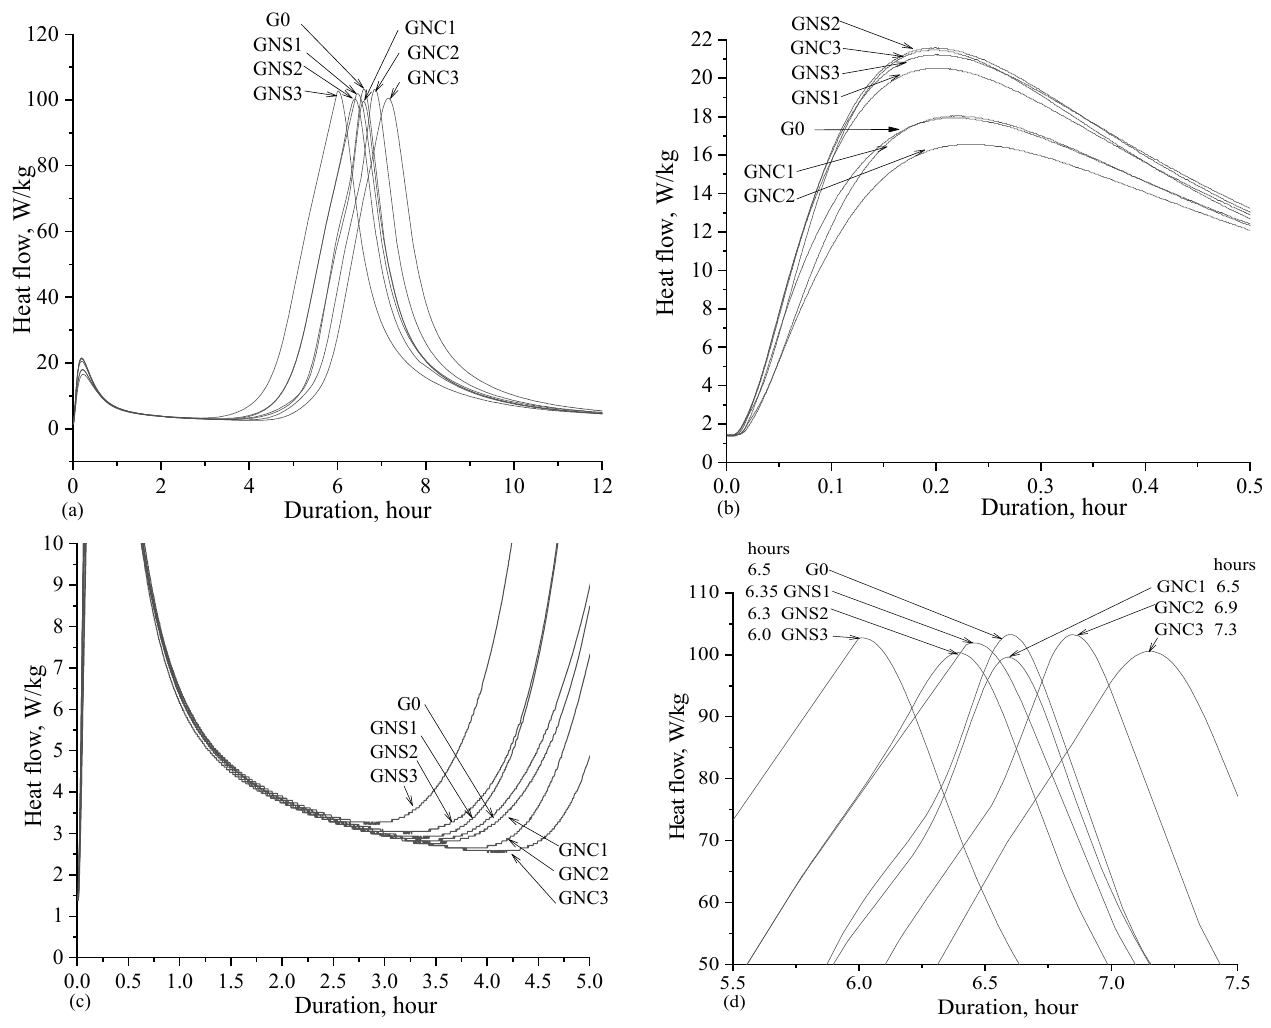
Figure 2. Heat flow curves of cement pastes with NS and NC admixtures ( a – d ).